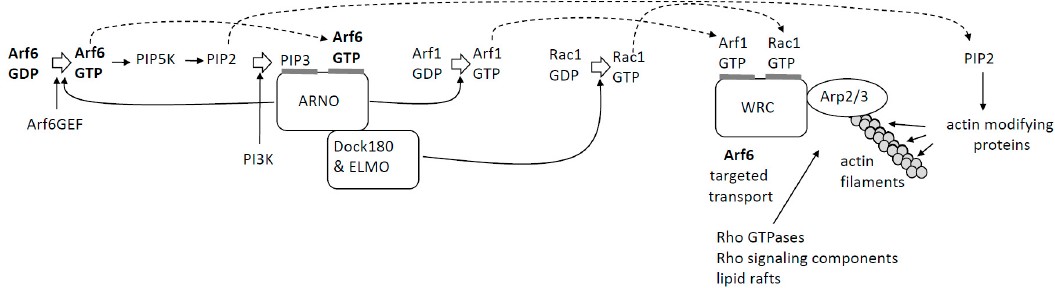
Figure 3. A schematic overview of Arf6’s role in actin polymerization. Dashed arrows indicate that the product is used in another step.